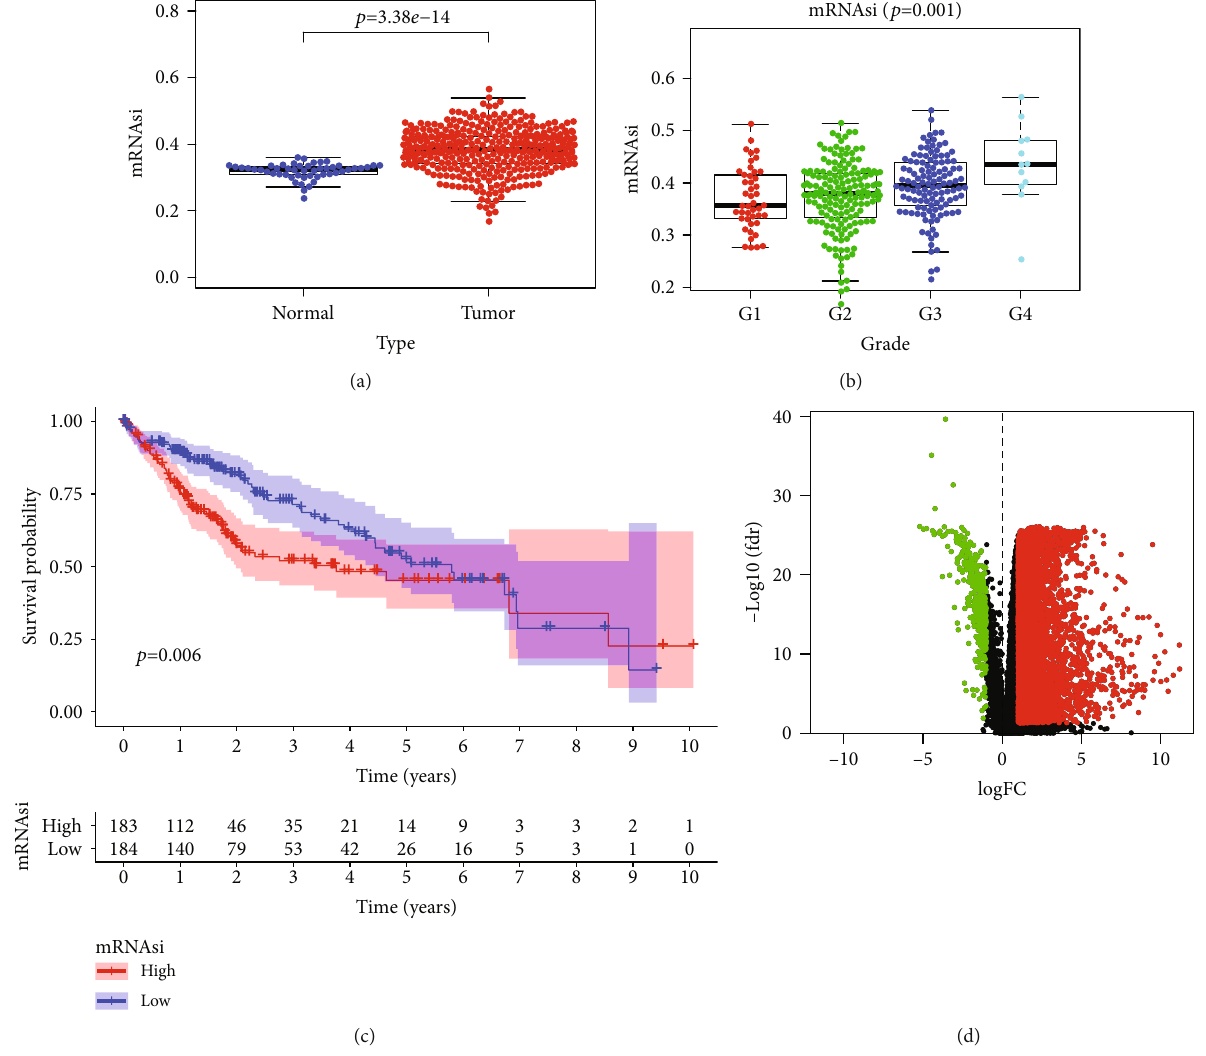
Figure 2: Stemness-characteristic index and its prognostic signi fi cance in HCC. (a) Di ff erences in mRNAsi between HCC and matched normal liver tissues in the TCGA dataset. (b) Comparison of mRNAsi among HCC subgroups divided by pathological grades. (c) Kaplan- Meier curves of patients assigned to high- and low-risk groups based on the mRNAsi value in the TCGA dataset. The prognosis of the high-mRNAsi group was poorer than that of the low-mRNAsi group. (d) Volcano plot showing DEGs in HCC samples. Green indicates downregulated of genes, and red indicates upregulated of